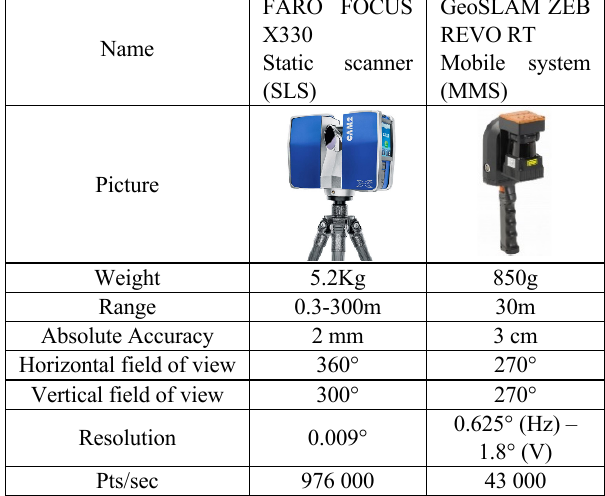
Table 1. Characteristics of the acquisition systems